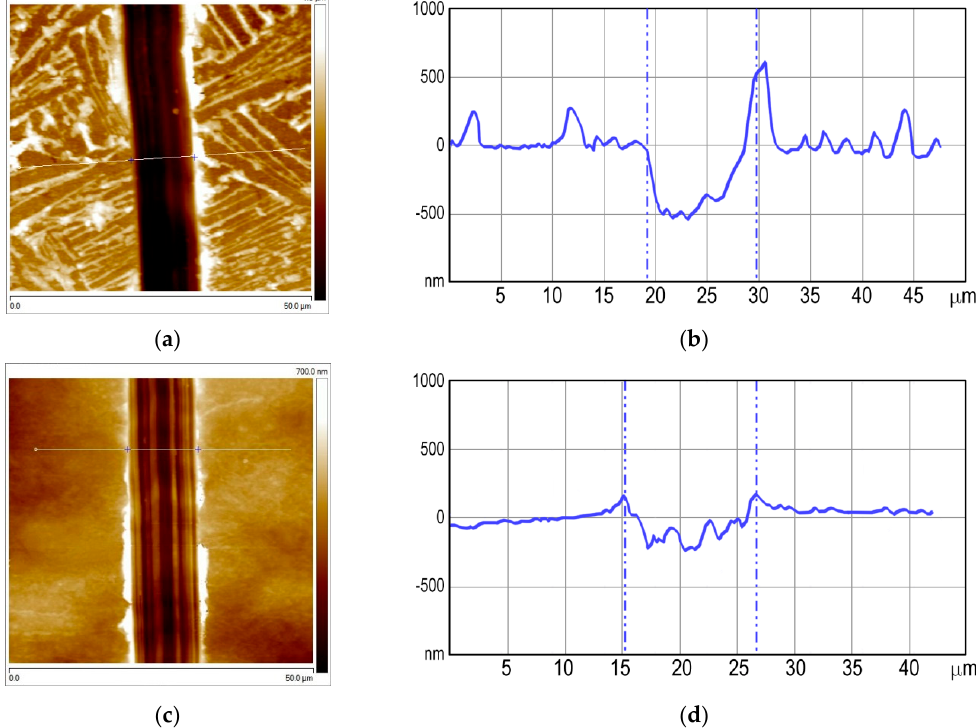
Figure 4. AFM images ( a,c ) and corresponding cross-sectional surface profiles ( b,d ) of scratch grooves formed at the applied load of 200 mN in Ti-6Al-4V alloy samples with lamellar ( a,b ) and bimodal ( c,d ) microstructures.